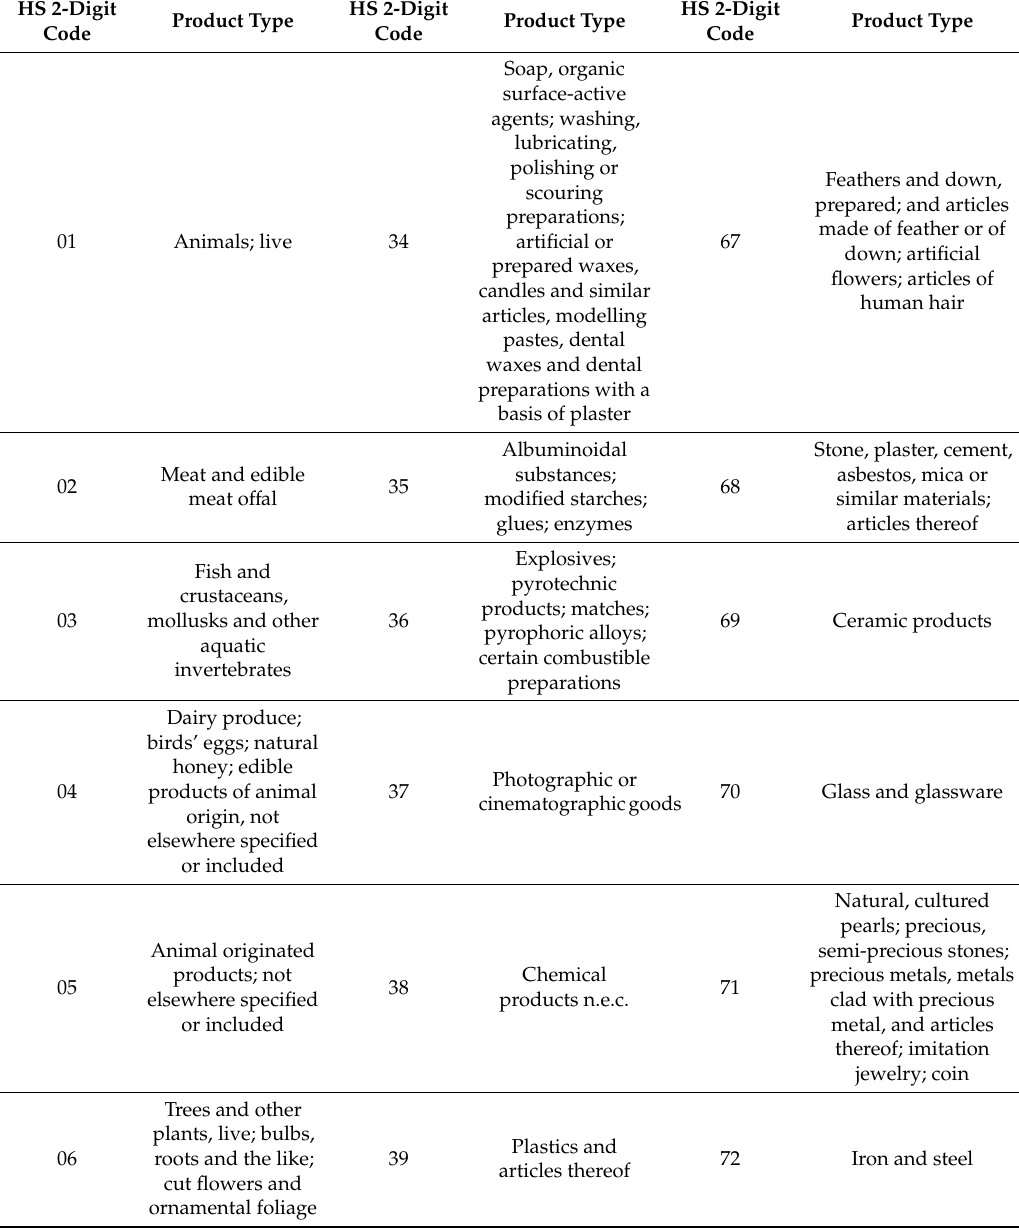
Table A1. Mapping table of HS 2-digit code and product